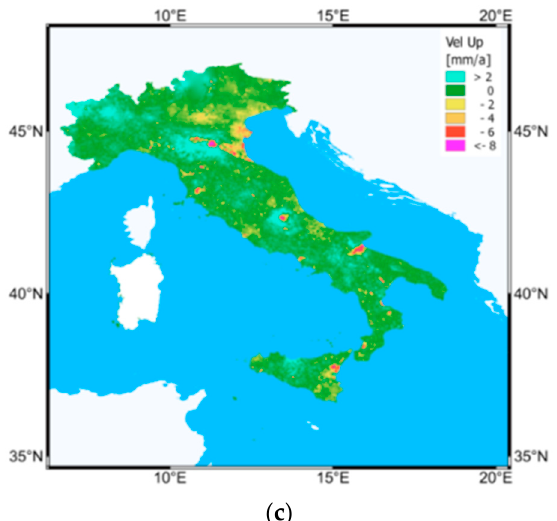
Figure 8. Velocity field components derived by the combination of GNSS and PS radar interferometry related to the Eurasian reference system(ETRS89). a —North component: velocities higher than 5 mm/a toward the North are plotted in a red scale color, white for velocities around 2.5 mm/a and stable part are in blue, no movements toward the South are recorded. b —East component: the values in red indicate movement towards the East, and values in blue indicate movement towards the West; the relative stabilities are plotted in white. c —Vertical component: Cyan represent uplift, green represents the stable part, and colors from yellow to violet represent a downward